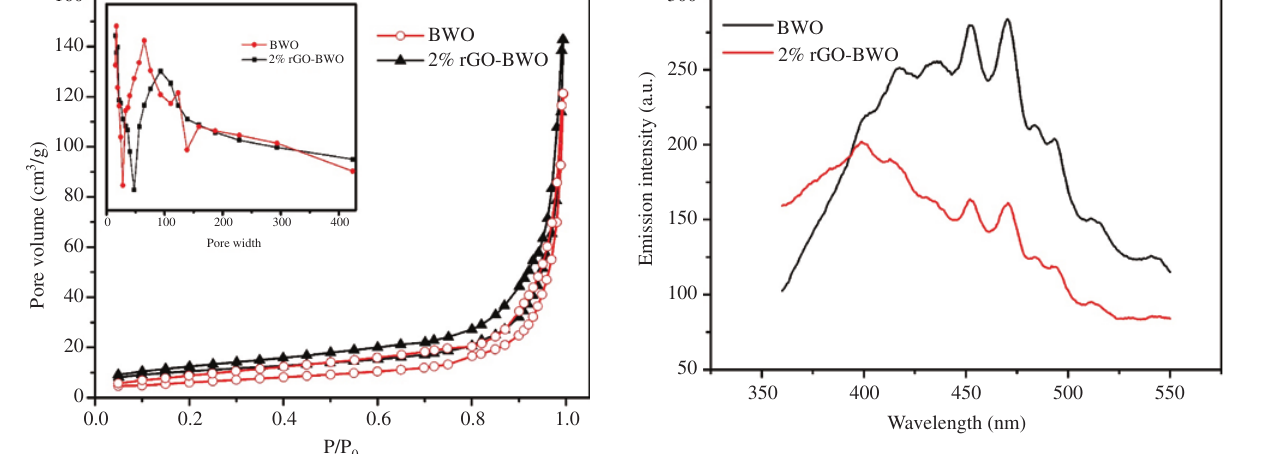
Figure 6: Nitrogen adsorption-desorption isotherms of the BWO and rGO-BWO samples. Inset: the pore size distribution curves of the BWO and rGO-BWO samples.